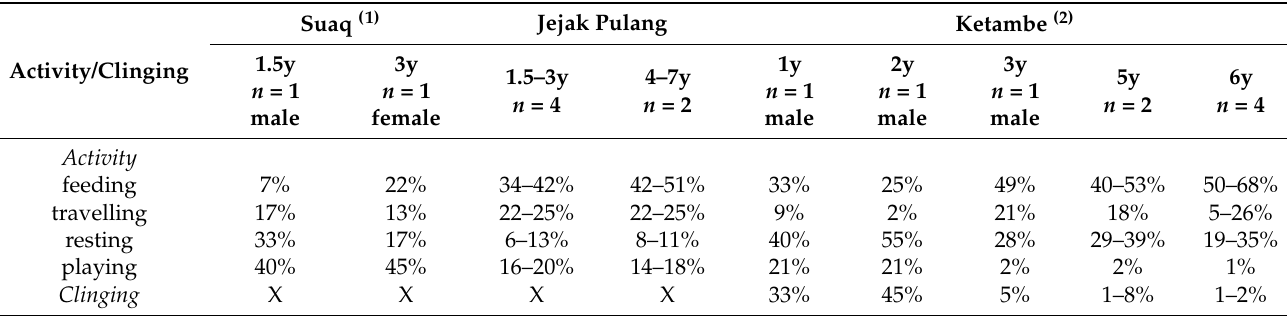
Table 6. Comparison of activities among mother-reared infants and our orphaned orangutans.